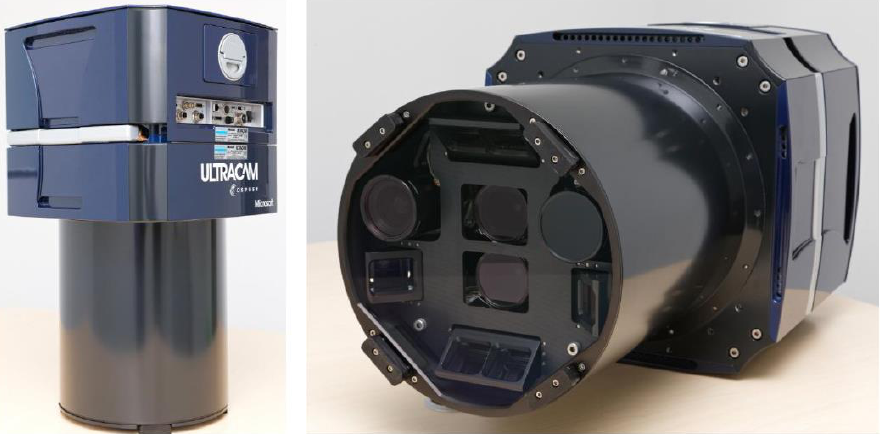
Figure 1: UltraCam Osprey (left) and cone layout (right)